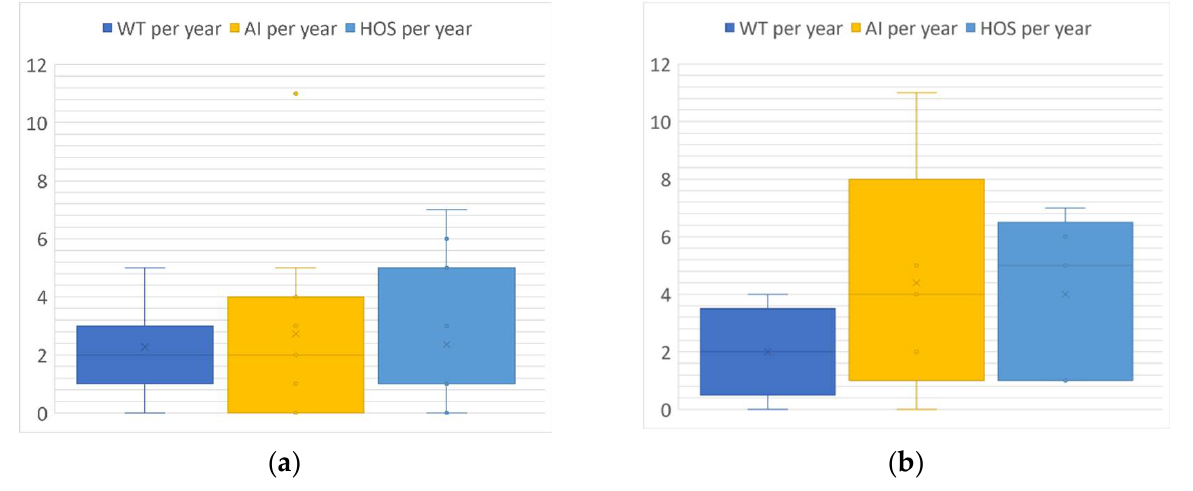
Figure 3. Boxplot of papers published per year for wavelet transform, artificial intelligence, and higher-order statistics for: ( a ) last 10 years; ( b ) last 5 years.